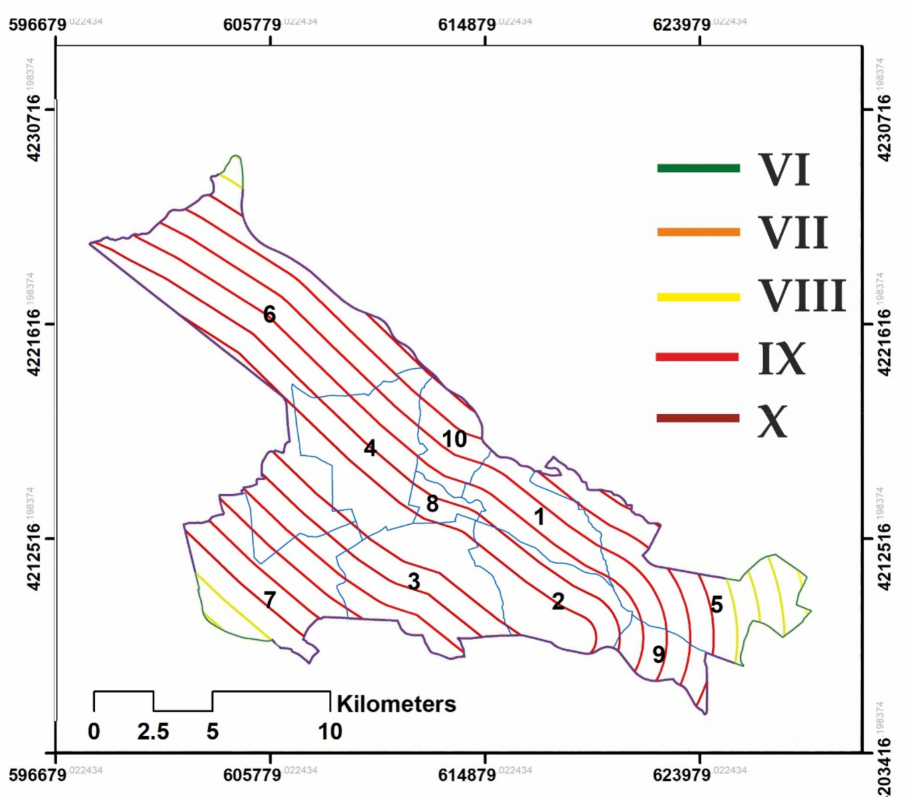
Figure 7. Intensity map of a 7.3 (1721) magnitude earthquake (the Roman numerals represent the Modified Mercalli Intensity).